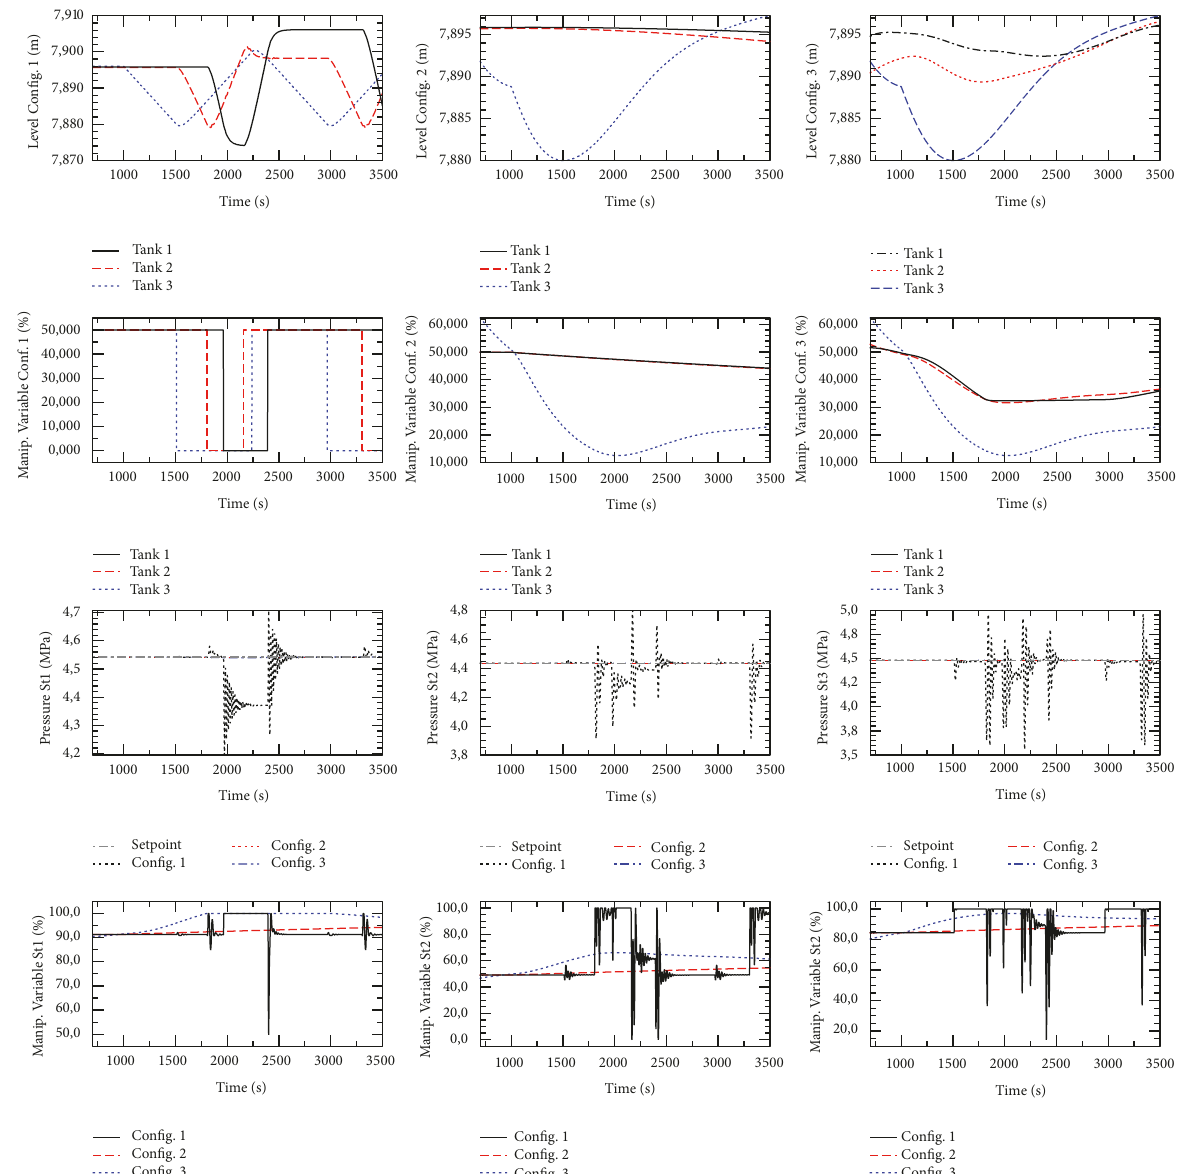
Figure 9: Level and Pressure Response, under disturbances, for Configurations 1, 2, and 3.